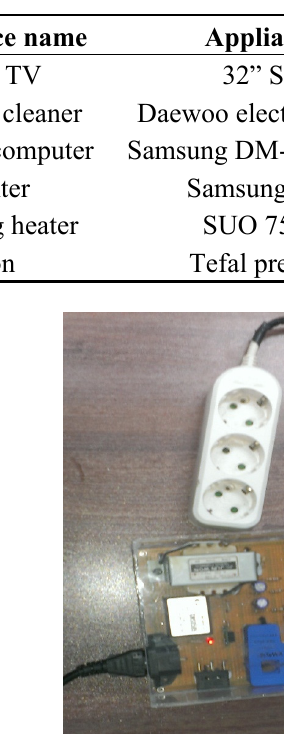
Table 3. Appliance power ratings.